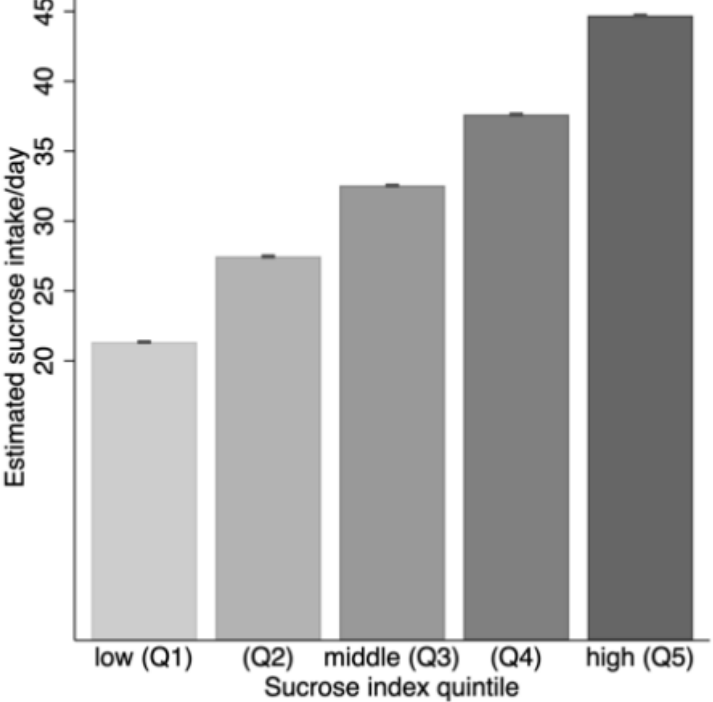
Figure 7. Bar graph illustrating mean (SD) estimated daily sucrose intake (g/day) by quintile groups based on the sucrose index value distribution in the replication cohort.